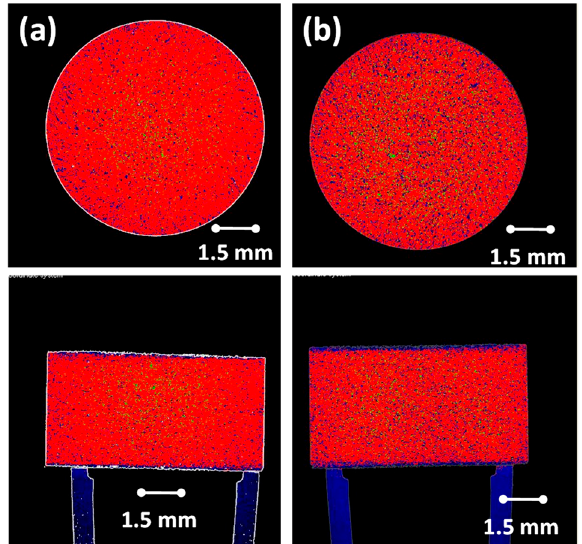
Figure 5. X-ray micro-tomographic images of sagittal and transverse sections through ( a ) CR and ( b ) DC formulation compacts. Images depict the homogeneity of the formulation mix.